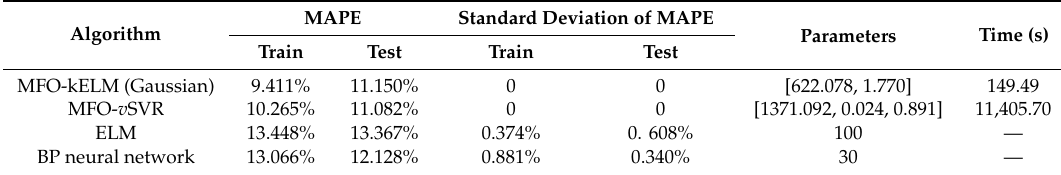
Table 6. kELM compared with other regression algorithms.